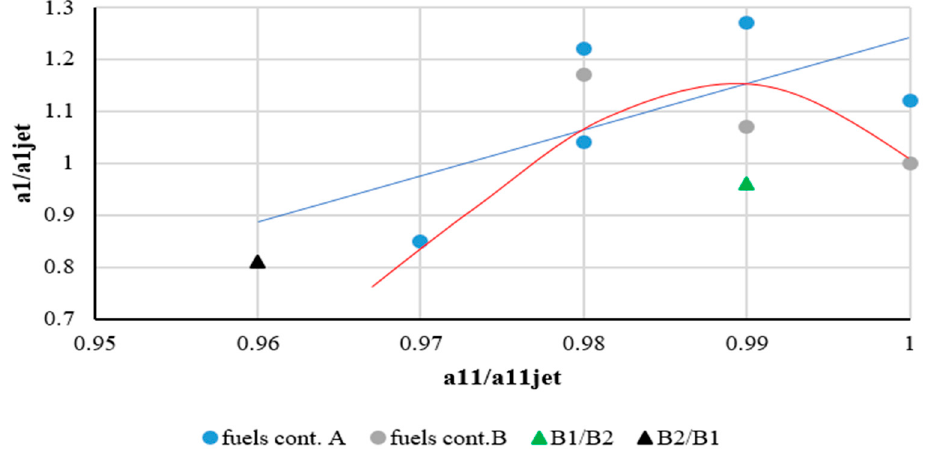
Figure 12. Relationship between a 1 /a 1jet and a 11 /a 11jet values (relationship between the criteria of similarity for the combustion process sequence, based on measuring CO content in exhaust gases and combustion chamber temperature gradient (T 3max − T 2 ) / (T 3min − T 2 )).